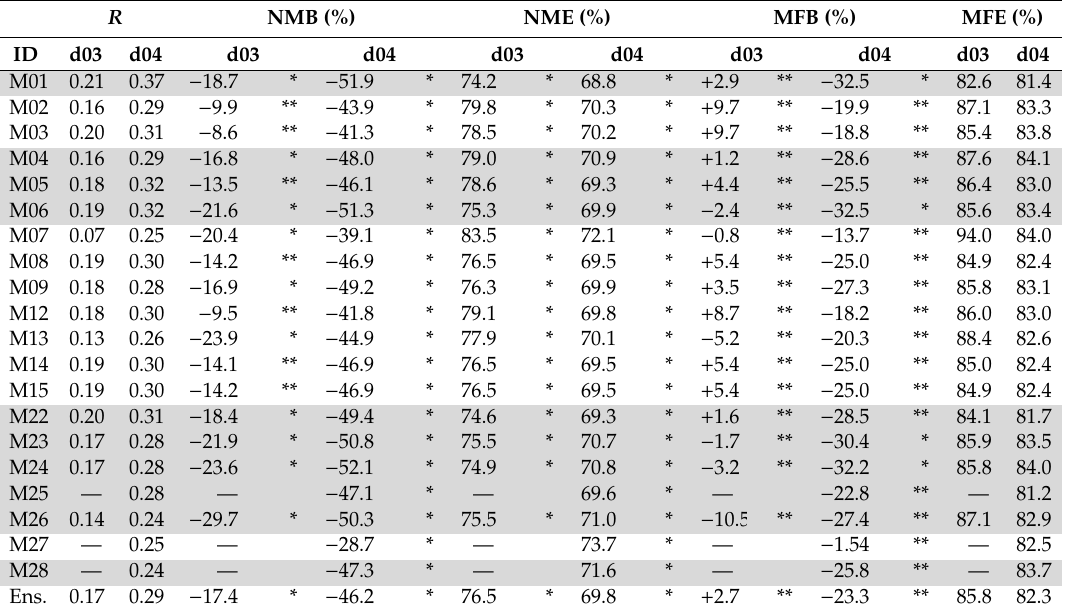
Table 2. Statistical analysis of model performances for NO 3 − over domains 3 and